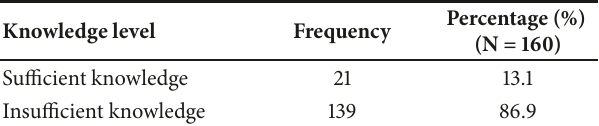
Table 3: Knowledge of midwives on evaluation of newborn babies.